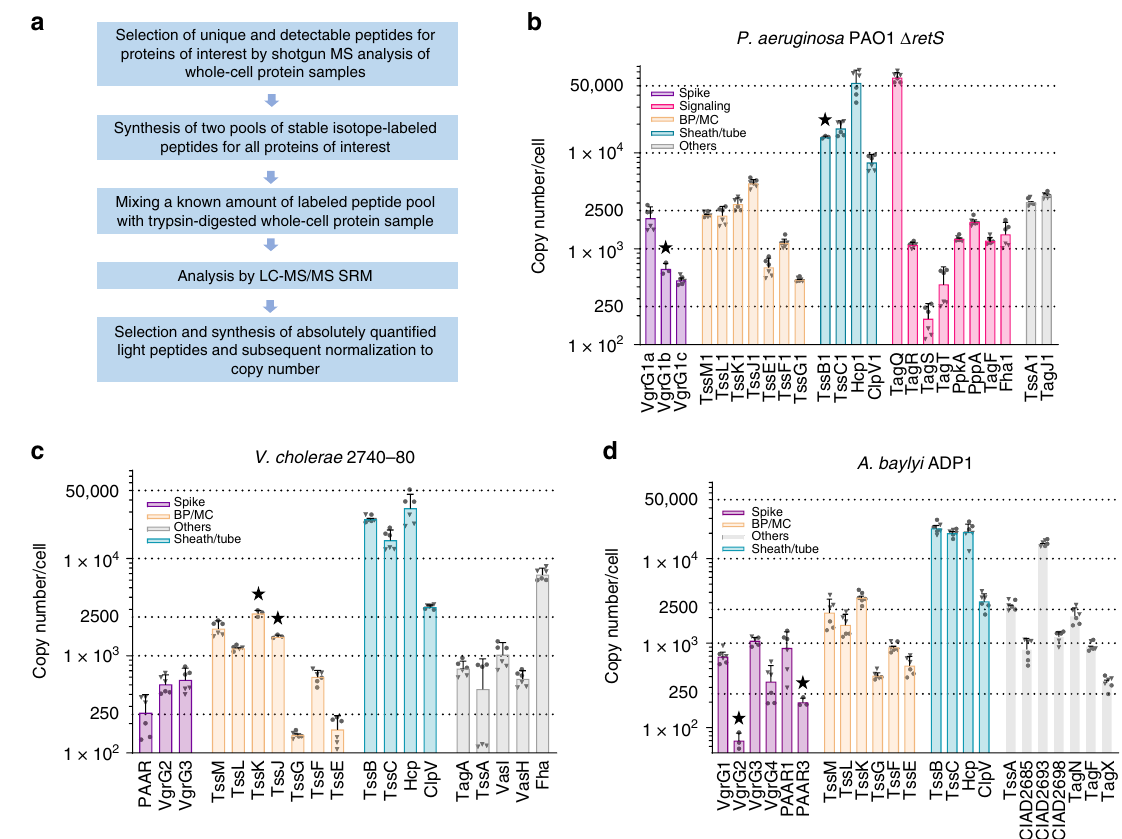
Fig. 2 Abundance of T6SS components in different bacteria. a The overall experimental procedure for determining the abundance of proteins in this work. b The absolute copy number of each selected component of H1-T6SS in whole cell lysate of P . aeruginosa PAO1 ( Δ retS background) grown to OD 600 1.2 – 1.5. c The absolute copy number of each selected component of T6SS in whole cell lysate of wild-type V . cholerae 2740 – 80 grown to OD 600 1.2 – 1.5. d The absolute copy number of each selected component of T6SS in whole cell lysate of wild-type A . baylyi ADP1 grown to OD 600 1.2 – 1.5. b – d The quanti fi cation of heavy peptides from the peptide mixes were determined using corresponding light quanti fi ed peptides in triplicates. All abundance measurements were performed in three independent biological experiments. Bar graph shows the average of copy number determined by two peptides (individual measurements shown with dots for peptide 1 or triangles for peptide 2), with error bar as the SD between measurements from both peptides if available; otherwise, SD between biological replicates is shown (highlighted with a star). Note the y ‐ axis is in Log 10 scale. All measurements are available in Supplementary Data 1. Source data are provided as a Source Data fi